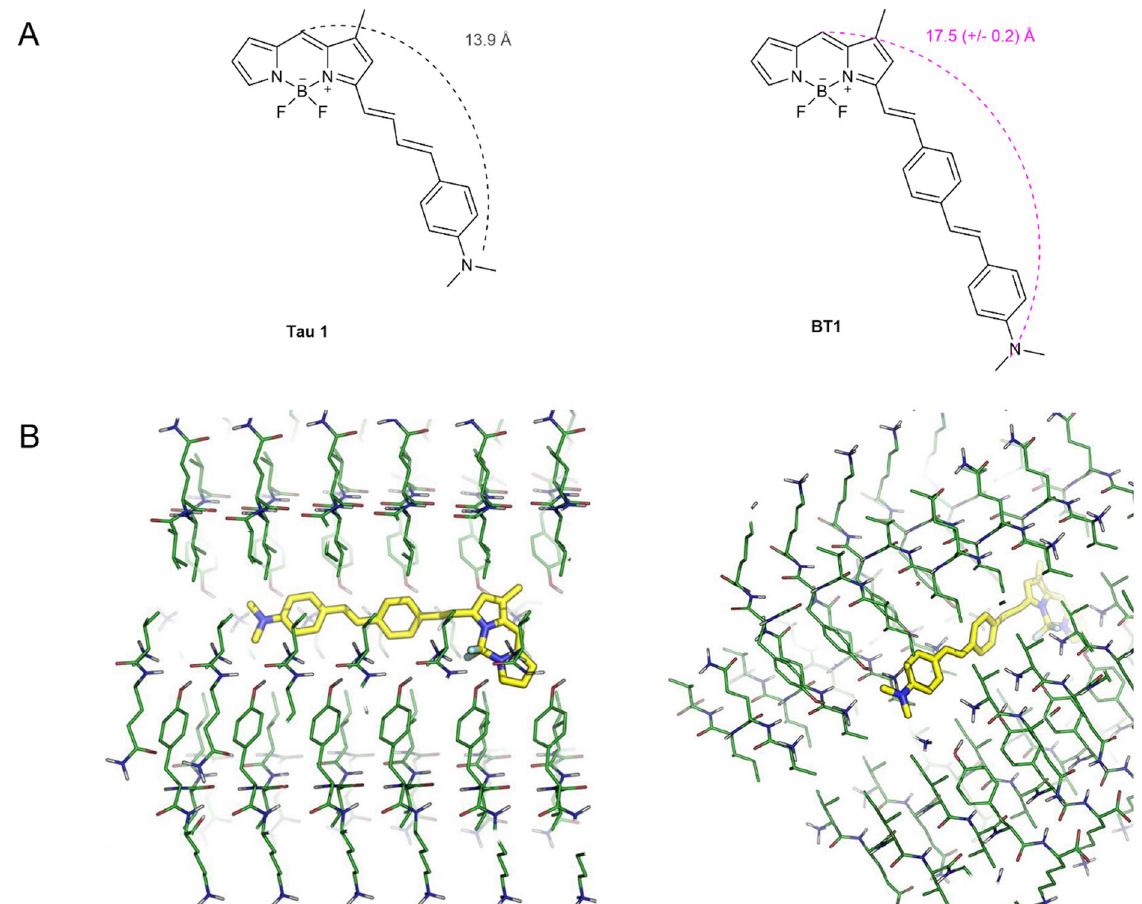
Figure 1. Chemical structures of BODIPY based fluorophores. ( A ) Chemical structures of TAU1 and BT1. (created by ChemDraw version 20.1.0.112 (112); PerkinElmer Inc) ( B ) Molecular docking of BT1 against the crystallographic structure of the PHF6 fragment: side and diagonal view of the molecule in the protein tunnel. (PyMOL Software. The PyMOL Molecular Graphics System, Version 2.2.0 Schrödinger, LLC. URL: https:// pymol.